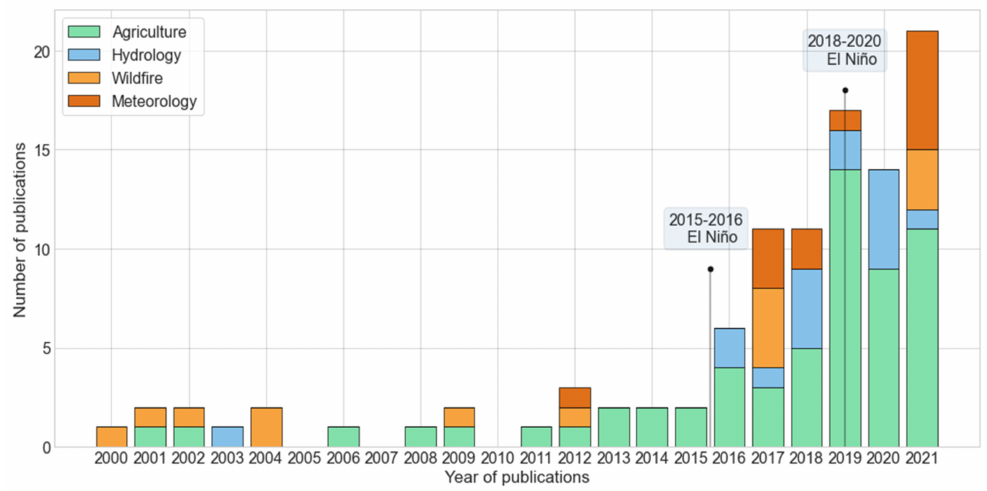
Figure 3. The bar plot shows the growing number of drought studies in Southeast Asia from 2000 to 2021. Agricultural drought had the largest number of publications, while hydrology and forest-related drought received the least